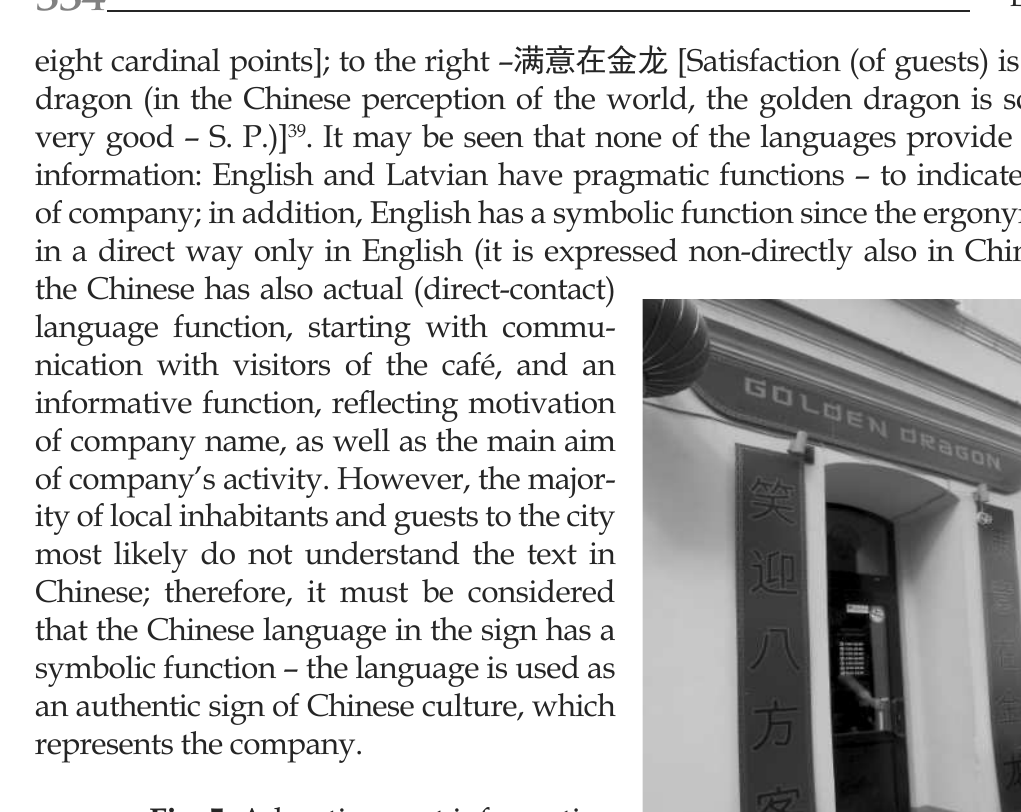
Fig. 5. Advertisement information outside